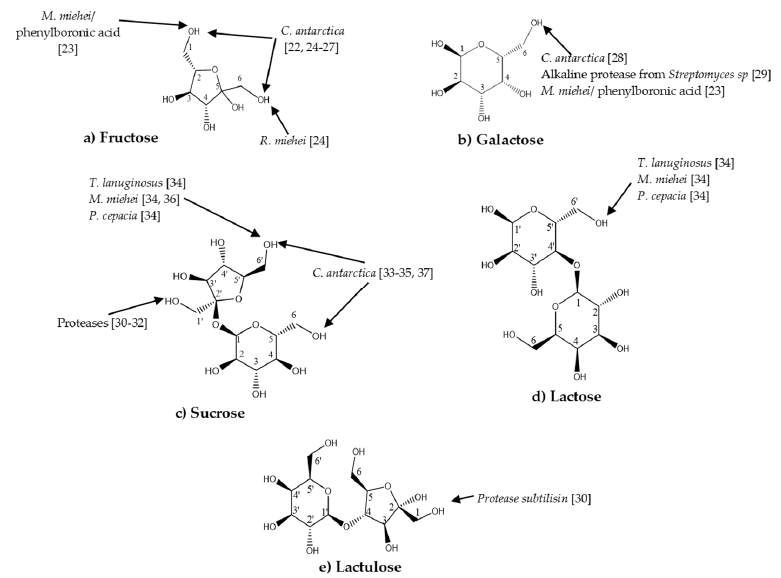
Figure 1. Acylation positions of several sugars with different biocatalysts.